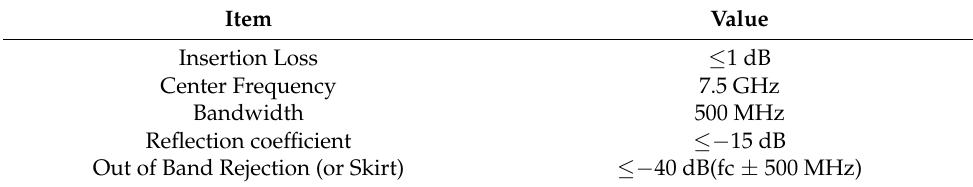
Table 1. Specifications the design will meet.